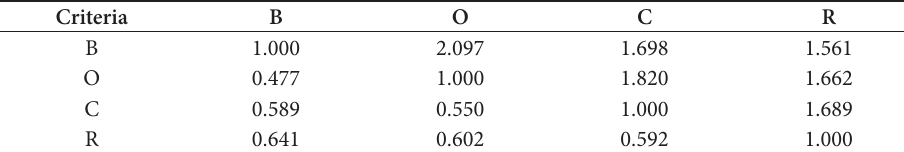
Table 1. Aggregate pairwise comparison matrix for criteria of level 2 Criteria B O C